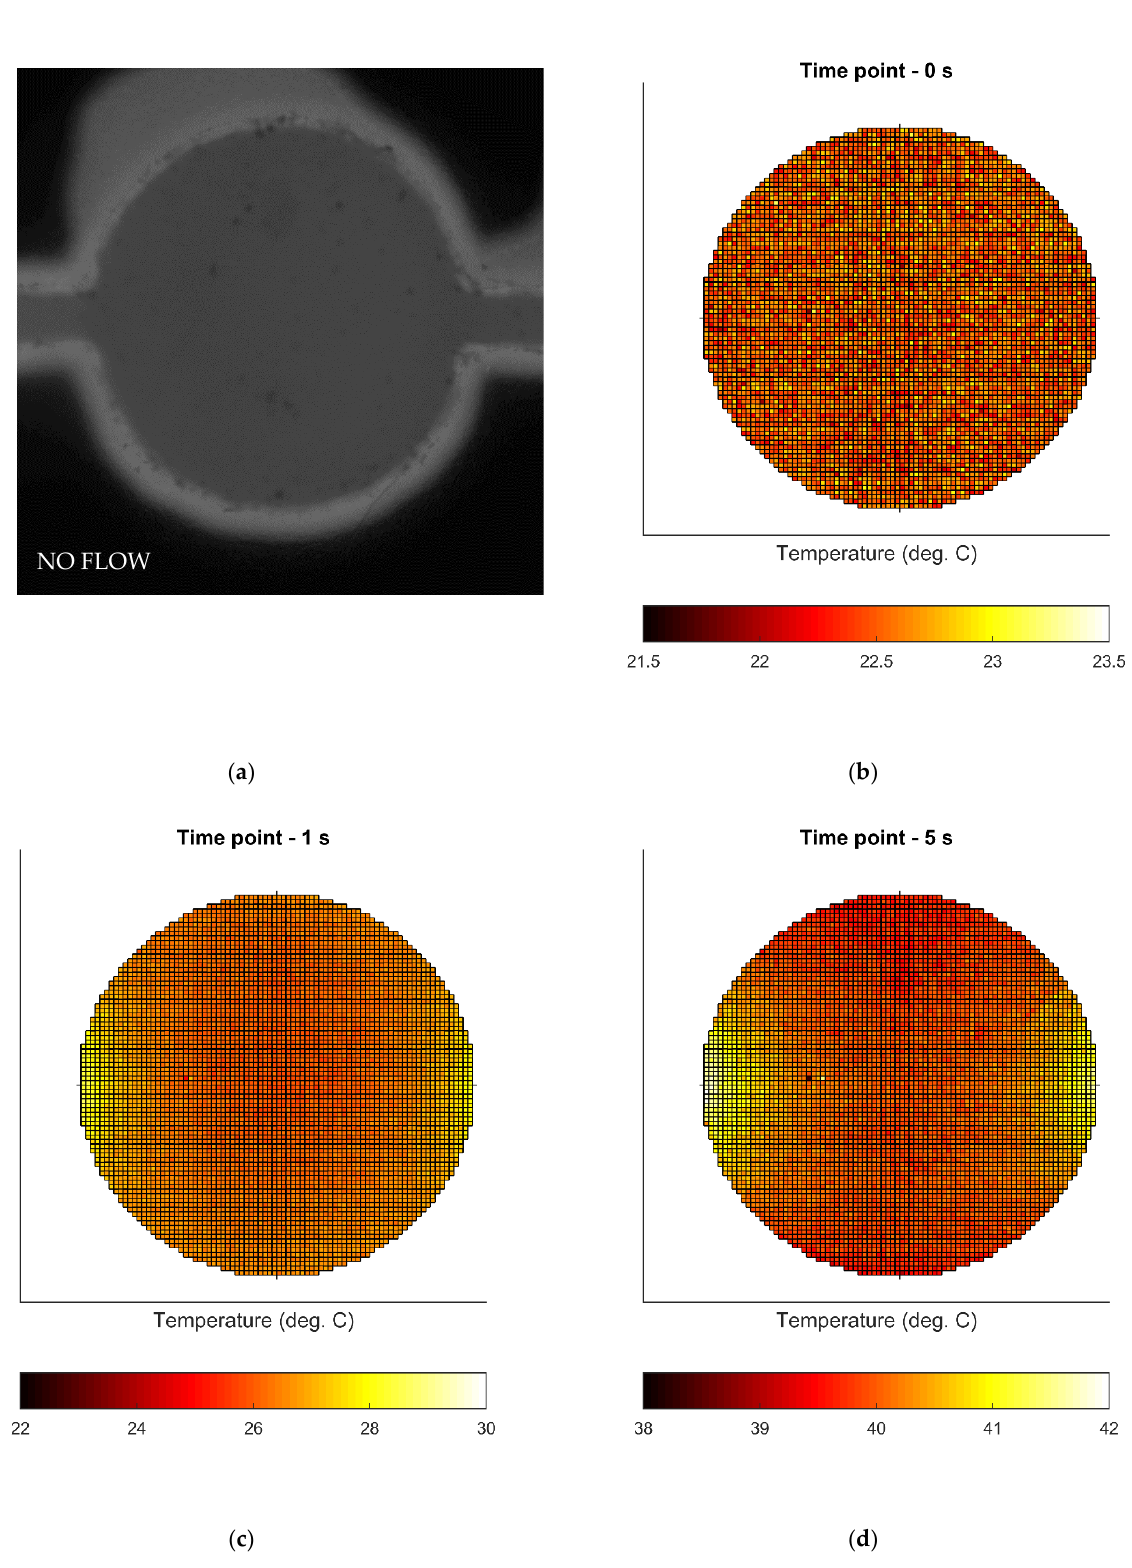
Figure 7. The no flow scenario. ( a ) The image of the fluorescent liquid loaded into the microwell before heating. ( b ) The temperature profile of the mixture in the microwell before heating. ( c ) The temperature profile of the mixture in the microwell after 1 s of heating. ( d ) The temperature profile of the mixture in the microwell after 5 s of heating.